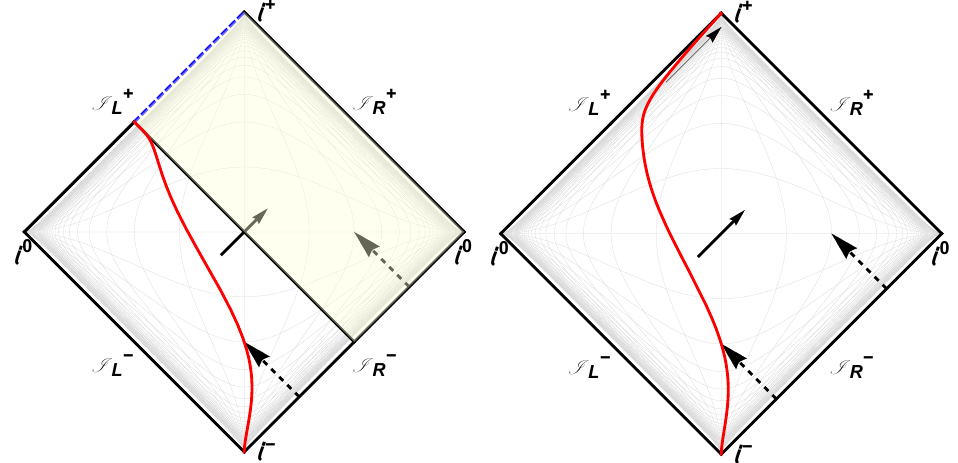
Figure 2. ( Left ) Penrose diagram for the case of the moving mirror (solid red line) which has a one-to-one correspondence to the usual evaporating black hole with information loss. The solid red line here is Equation (5), computed with κ ≡ 1/4 M = 1. Notice that the mirror goes light-like in the far future. The dashed blue line is the singularity analog where left-movers (opaque yellow region) get “trapped”, i.e. they fall into the black hole analog never to return or be observed by I + diagram for the case of the moving mirror (solid red line) which corresponds to the remnant end-state with no information loss. Ultra-late time outgoing reflected modes escape to null-infinity, I + a redshift dependent on the final asymptotic speed of the mirror, 1 > ξ > 0, where in the diagram, ξ = 0.9, for illustration. In this case, the solid red line, Equation (6), is calculated with κ = 1 and is always time-like, permitting all left-movers to reflect and become